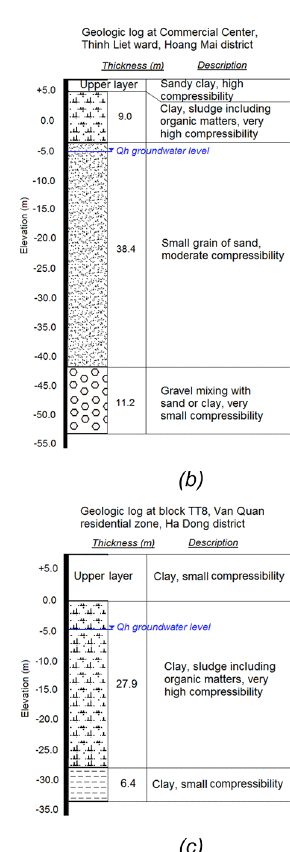
Fig. 7. (a) Geological map of second layer, (after Nguyen, 1996a) and averaged groundwater level in Q h aquifer interpolated from in situ measurements in 32 wells (after Vietnam Institute of Geosciences and Mineral Resources, 2010). Stratigraphic logs at (b) Hoang Mai district, (c) Ha Dong district (after Nguyen,